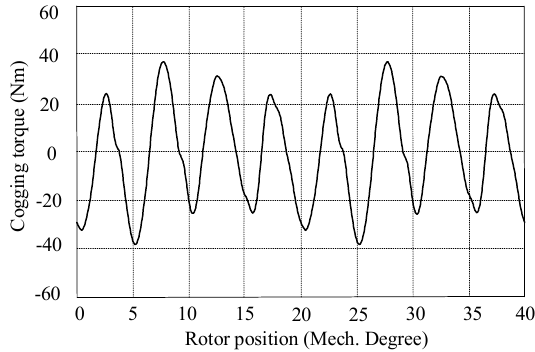
Rotor position (Mech. Figure 14. Cogging torque under rated field-excitation currents.